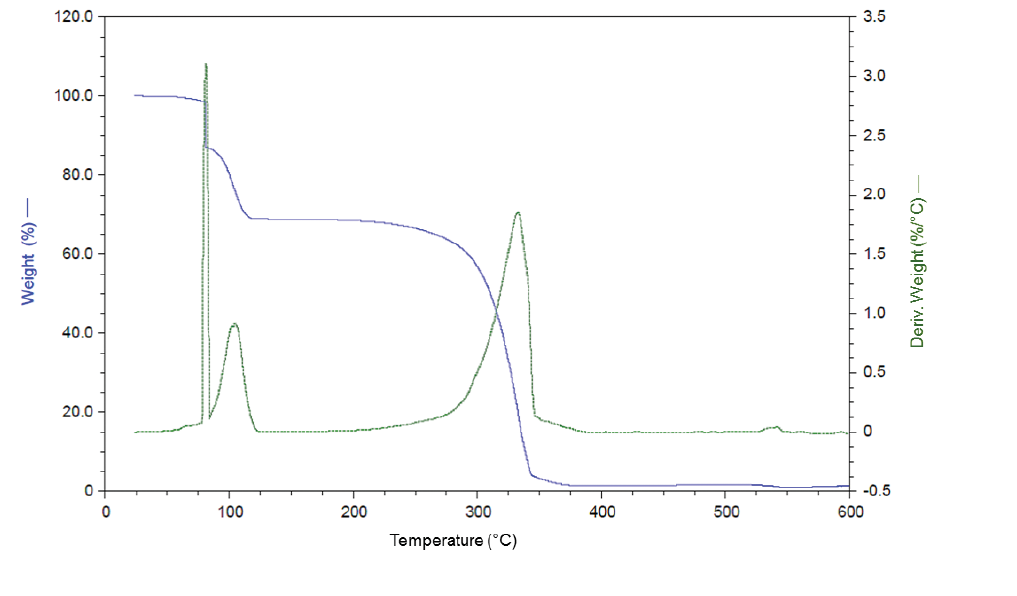
Figure 1: TG-DTG analyses of 1 at a heating rate of 5°C min − 1 under